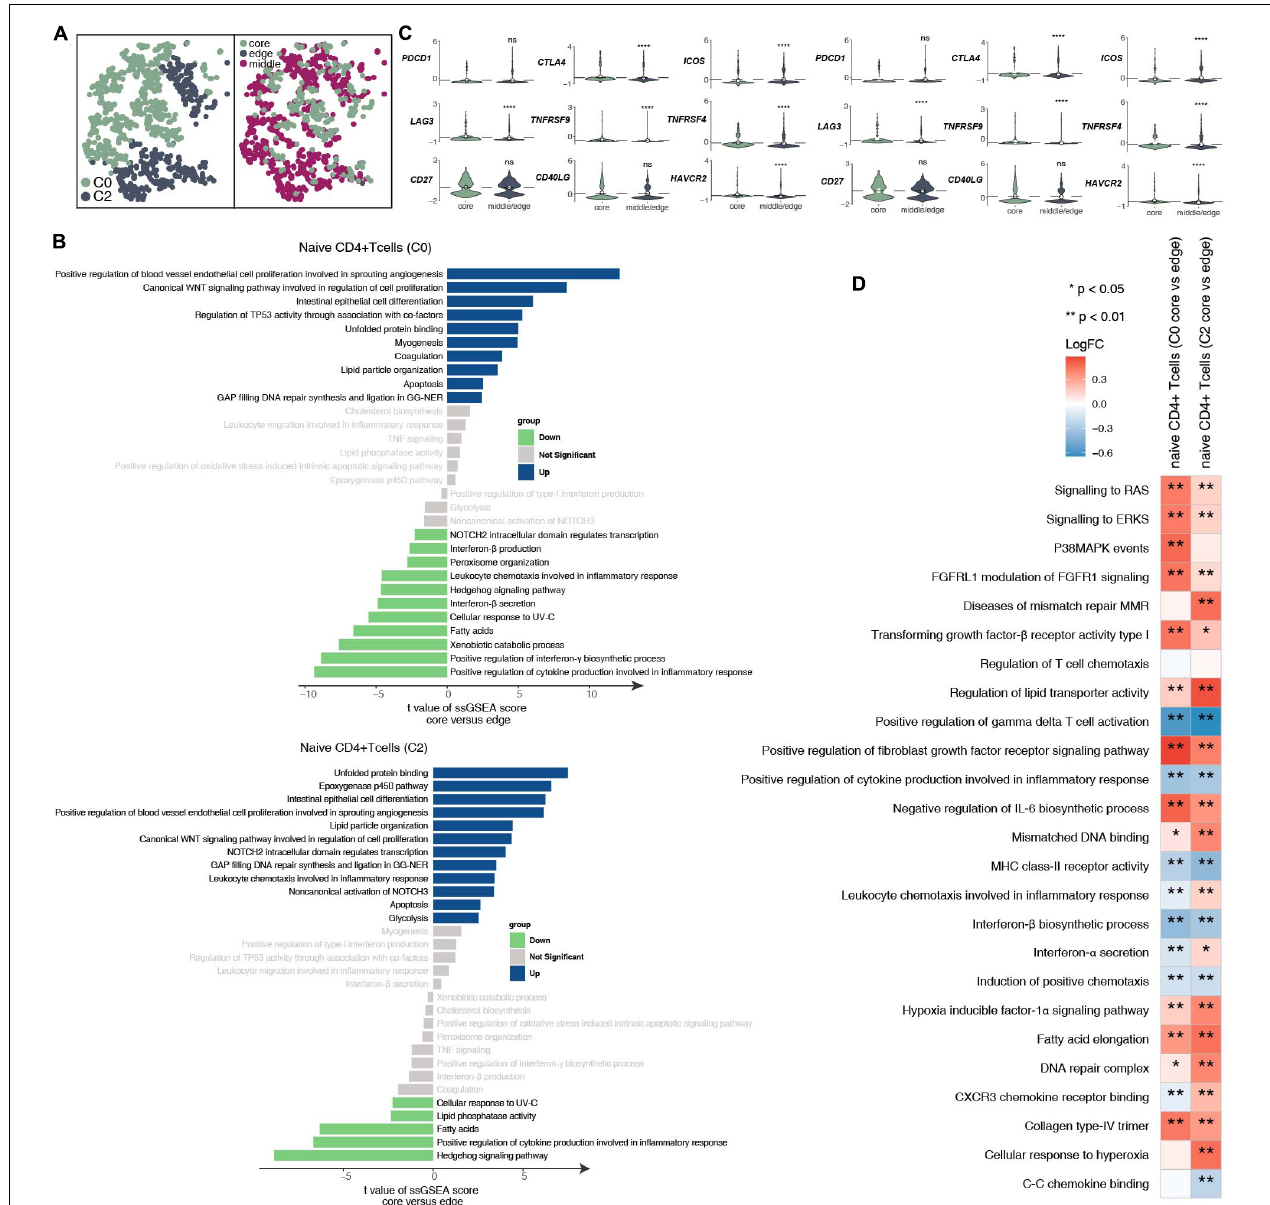
FIGURE 3 | CD4 + naive T cell clusters in LUAD. (A) tSNE plot of 932 CD4 + naive T cells, which are color-coded by their associated cluster or the sample location. (B) Differences in pathway activities scored per cell by GSVA between the tumor core and tumor edge in the CD4 + naive T cells (cluster 0) and CD4 + naive T cells (cluster 2). T -values are from a linear model. (C) Violin plots showing the smoothed expression distribution of selected genes involved in T cell activity and in immune checkpoints, stratified by CD4 + naive T cell clusters (clusters 0 and 2). (D) Heatmap depicting the mean differences in pathway activities scored per cell by GSVA between the tumor core and tumor edge across the CD4 + naive T cells (cluster 0) and CD4 + naive T cells (cluster 2). The x -axis of the heatmap indicates different CD4 + naive T cell clusters, and the y -axis indicates pathway activities scored per cell by GSVA. Each square represents the fold change or difference in each indicated pathway activity scored per cell by GSVA between the tumor core and tumor edge across the CD4 + naive T cells (cluster 0) and CD4 + naive T cells (cluster 2). Red indicates upregulation, while blue indicates downregulation. * P < 0.05; ** P < 0.01; **** P <